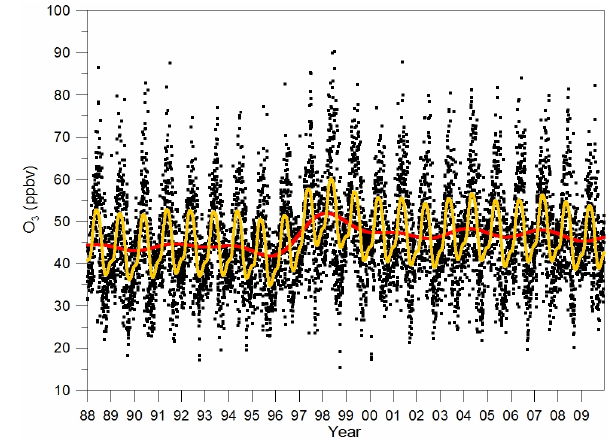
Fig. 2. Surface O 3 daily night means (black dots), inter-annual trend (red line) and inter-annual trend plus annual cycle at IZO from 1988 to 2009.